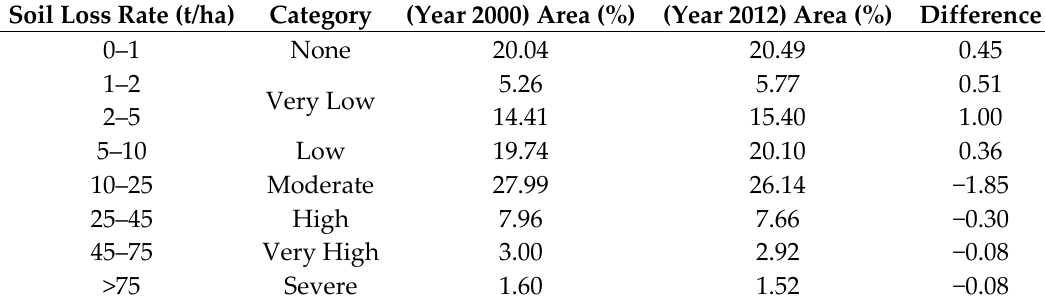
Table 3. Area occupied by each soil loss rate class for the years 2000 and